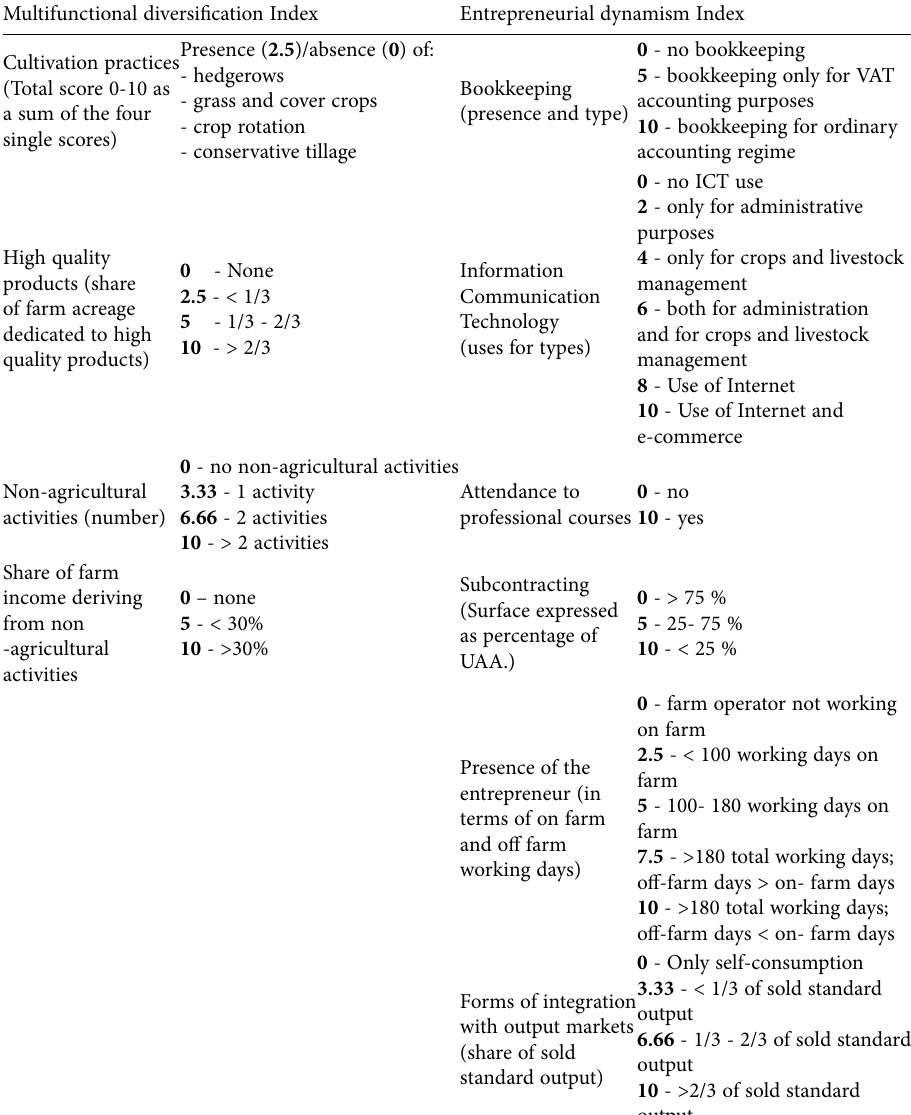
Table 3. Variables (and rules for their score assignment) composing the « multifunctional diversification » and the « entrepreneurial dynamism »